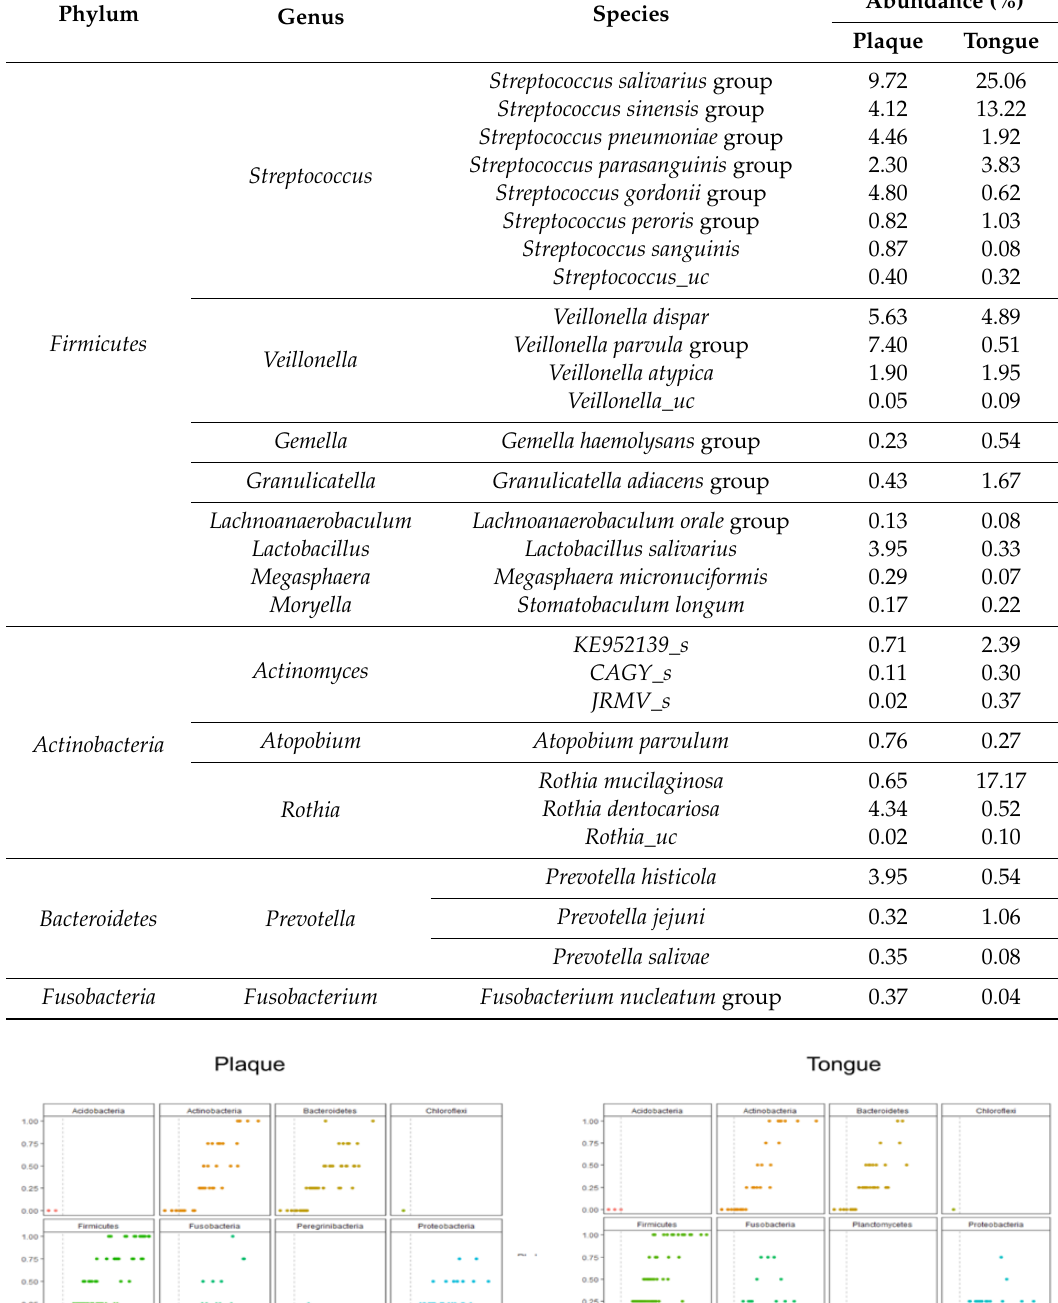
Table 1. Bacteria detected in denture plaque and tongue from all subjects.